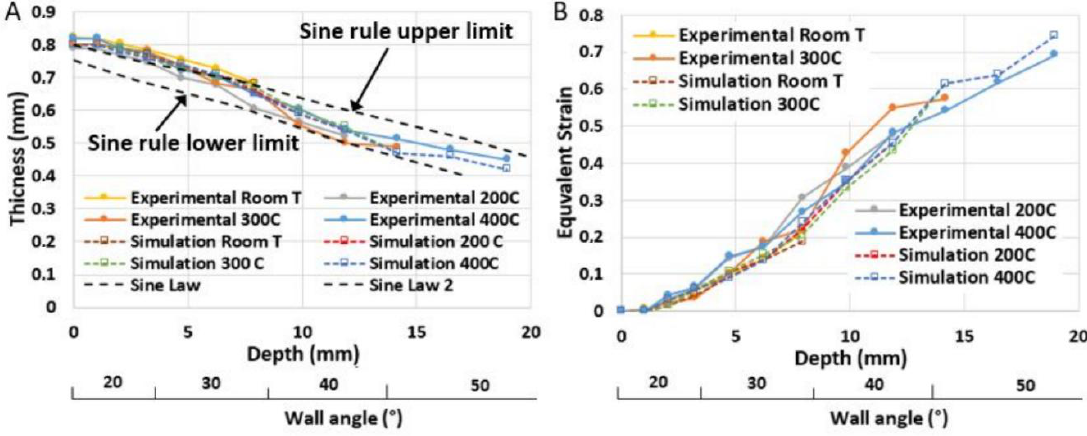
Figure 6. Checking the plane deformation mechanism experimented during SPIF tests.